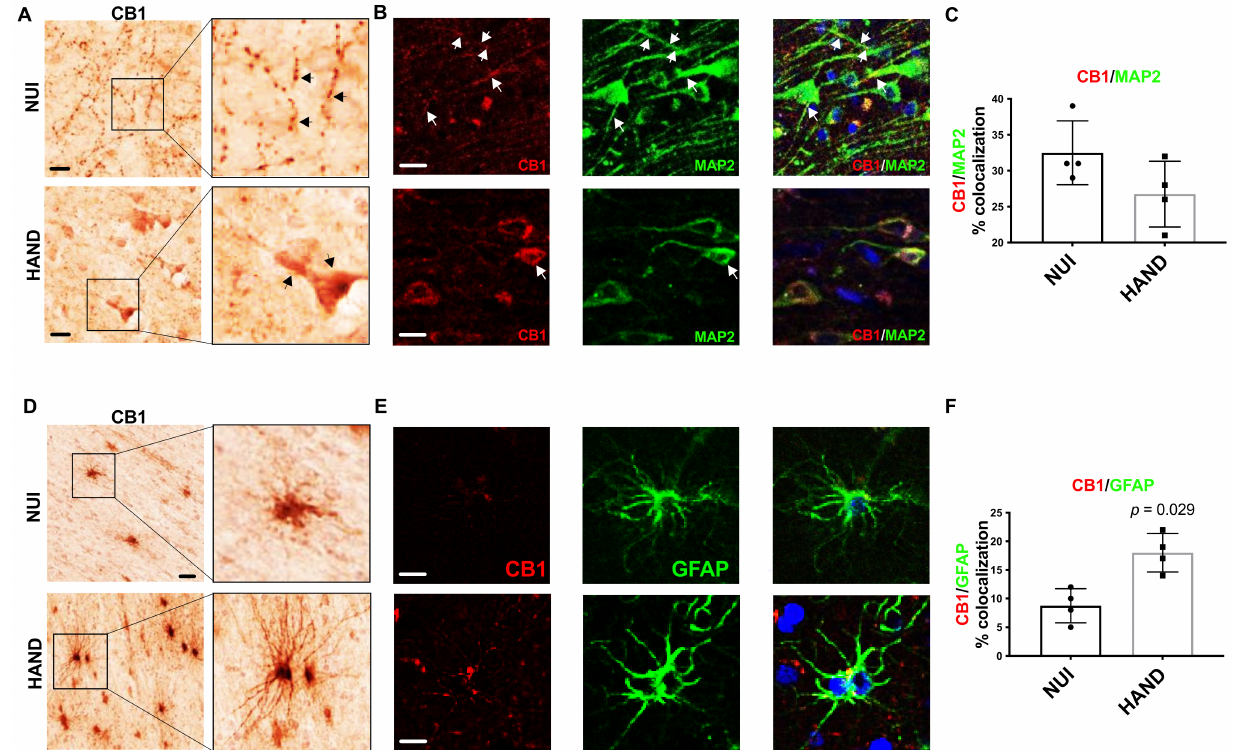
Figure 4. CB 1 expression and localization is altered in HAND brains on ART compared to NUI: ( A ) Immunostaining of CB 1 in the frontal cortices of NUI and HAND brain tissue. ( B ) Double-immunostaining of CB 1 and MAP2 in frontal cortices of HAND and NUI brain tissue. ( C ) CB 1 signal %colocalization of CB 1 /MAP2. ( D ) Immunostaining of CB 1 in the frontal cortices of NUI and HAND brain tissue and the quantification of CB 1 + glia. ( E ) Double-immunostaining of CB 1 and GFAP in frontal cortices of HAND and NUI brain tissue. ( F ) Quantification of %colocalization of CB 1 /GFAP. Statistical significance was determined by Mann–Whitney test; Error bars represent standard error of the